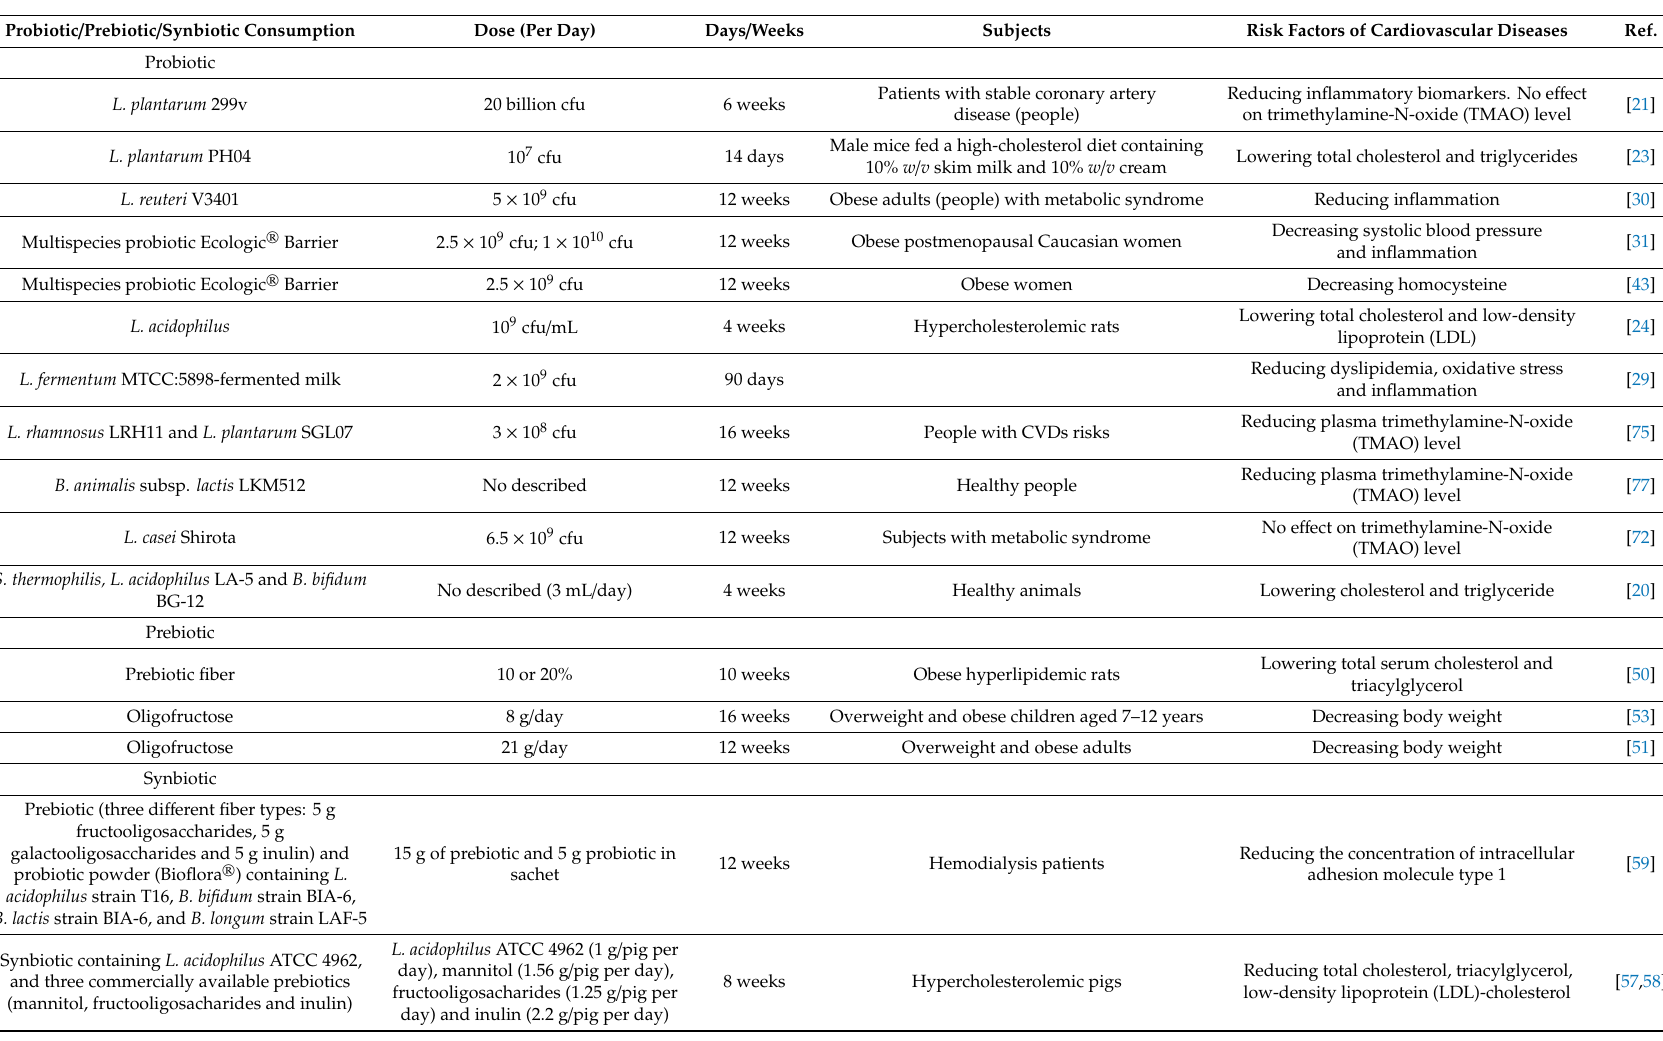
Table 1. The e ff ect of probiotics, prebiotics, and synbiotics on various risk factors of cardiovascular diseases ( in vivo model). Probiotic / Prebiotic / Synbiotic